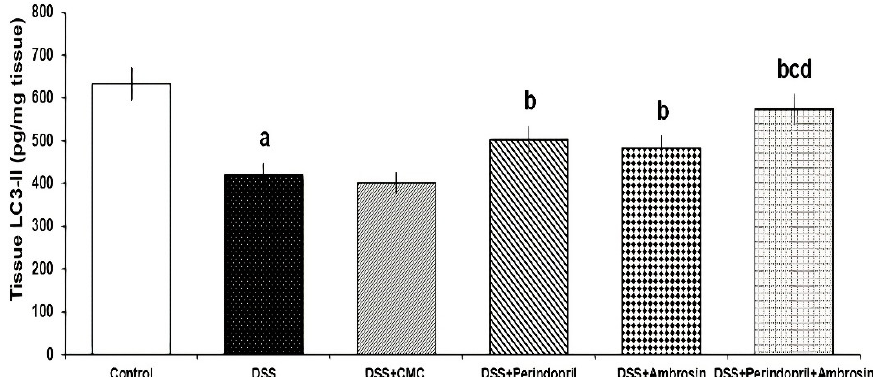
Figure 3. Effect of perindopril with or without ambrosin on beclin-1 and LC3-II levels in the colonic tissues of DSS-treated mice (Mean ± SD); where “a” denotes significant vs. the control group ( p -value less than 0.05); “b” denotes significant vs. DSS group ( p -value less than 0.05); “c” denotes significant vs. DSS + perindopril group (p-value less than 0.05); “d” denotes significant vs. DSS + ambrosin group ( p -value less than 0.05).